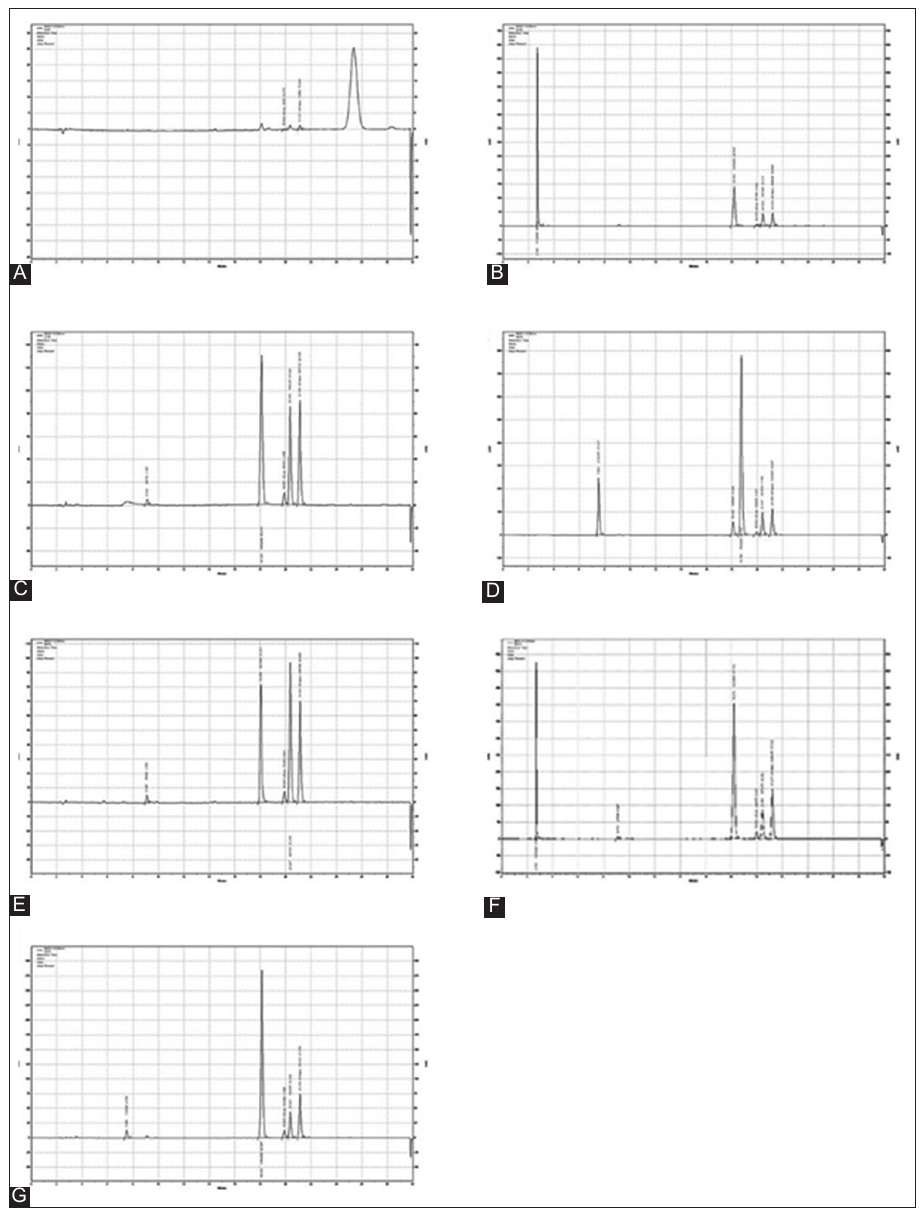
FIGURE 4. Analysis of six samples of sunscreen preparations available on the market of Bosnia and Herzegovina. Chromatogram of sample AV50 (a), sample EU30 (b), sample LP50 (c), sample MB30 (d), sample MZ15 (e), sample NK50 (f), sample OS1